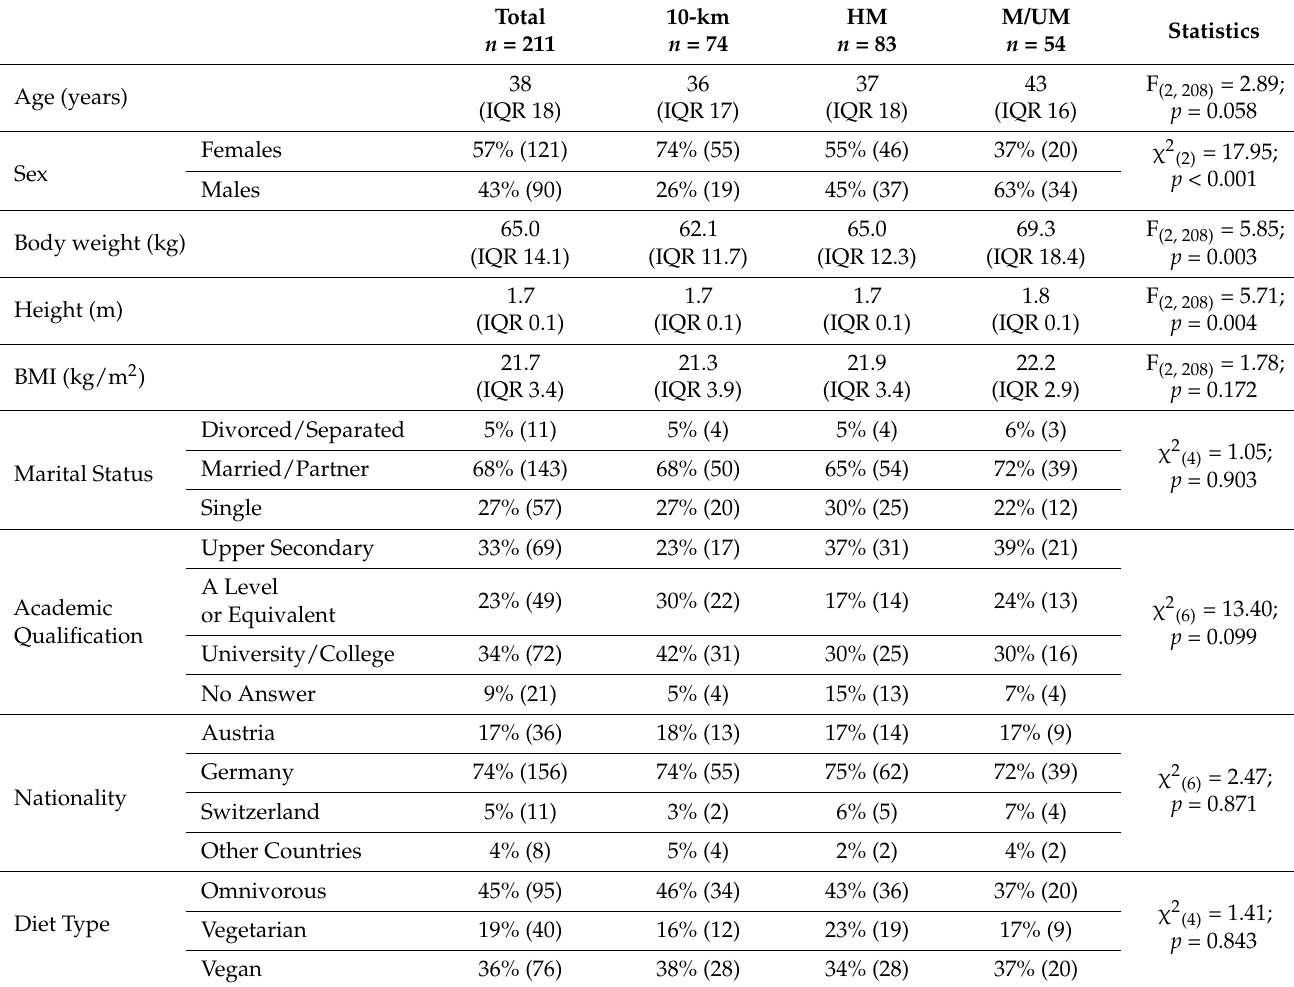
Table 2. Sociodemographic characteristics of the runners across race distance groups. Total n =